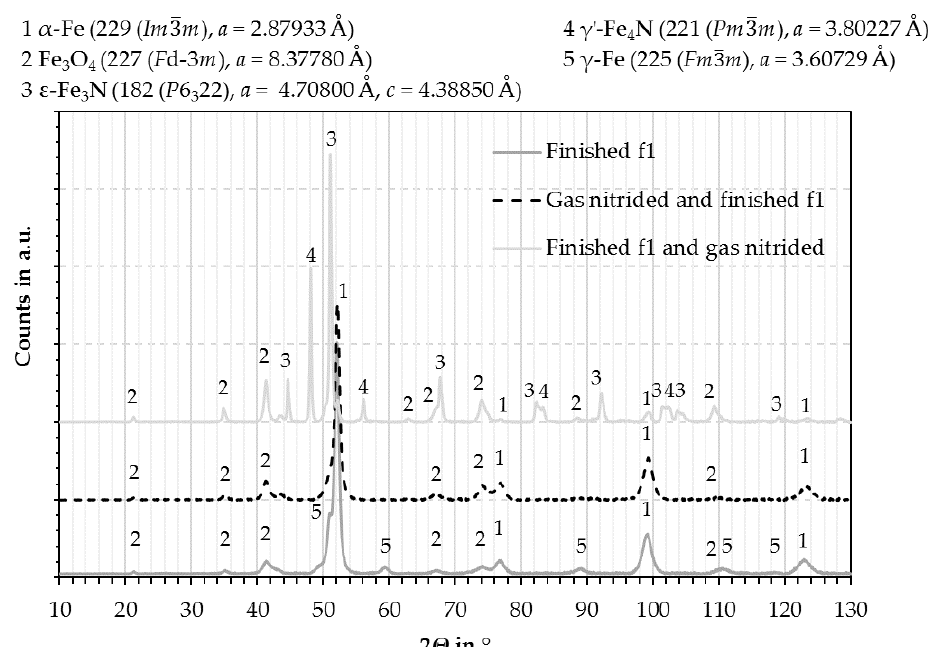
Figure 2. X-ray diffraction diagrams of the arc sprayed 17Cr steel coatings in the finished and gas nitrided state.